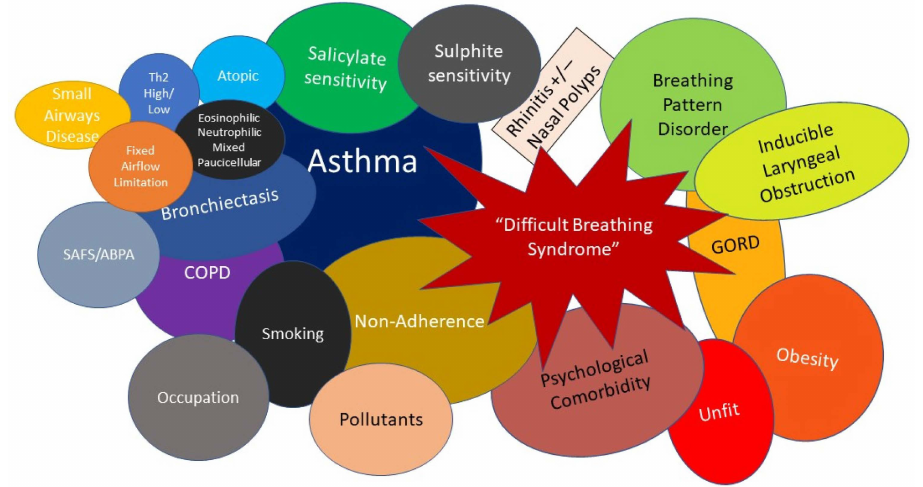
Figure 1. Schematic diagram of the “Difficult Breathing Syndrome” in difficult asthma. T2—Type 2 inflammation, ABPA—Allergic Bronchopulmonary Aspergillosis, SAFS—Severe Asthma with Fungal Sensitisation, COPD—Chronic Obstructive Pulmonary Disease, GORD—Gastro-oesophageal reflux